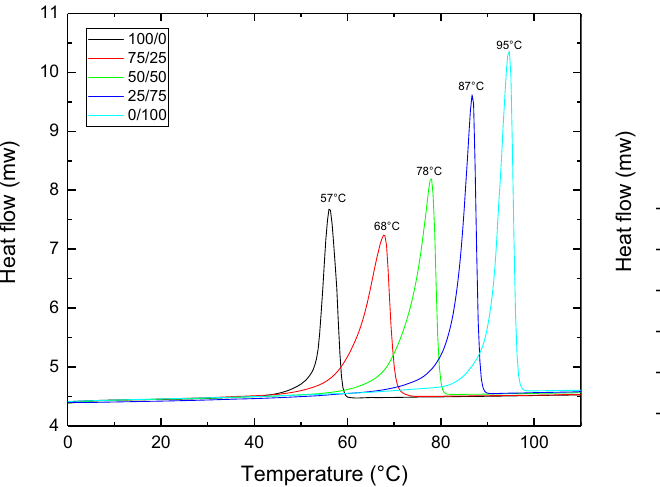
Figure 7: DSC cooling curves of MW - synthesized copolyesters CL –